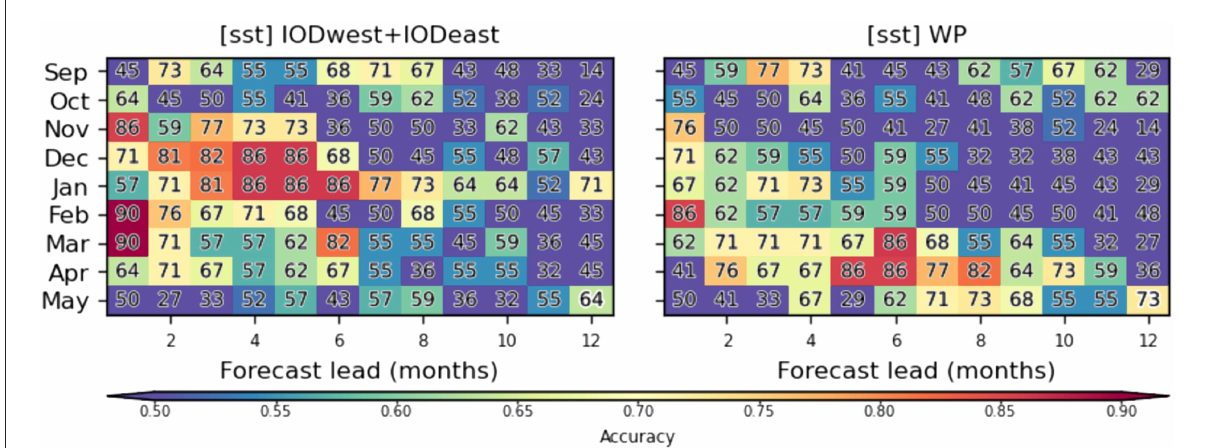
FIGURE6 Seasonal cycle of malaria prediction skill. Prediction accuracy is shown in function of target malaria prediction month (y-axis) and prediction lead (x-axis) for (left) exp1 which makes use of SST-based climate indices over the tropical Indian Ocean (IOD) and (right) SST over the western Pacific (WP; exp10). The skill is assessed with a multi-model voting ensemble composed of the three best classifiers selected for each lead/month combination. Accuracy is illustrated and indicated with numbers and colors as in Figure 5.